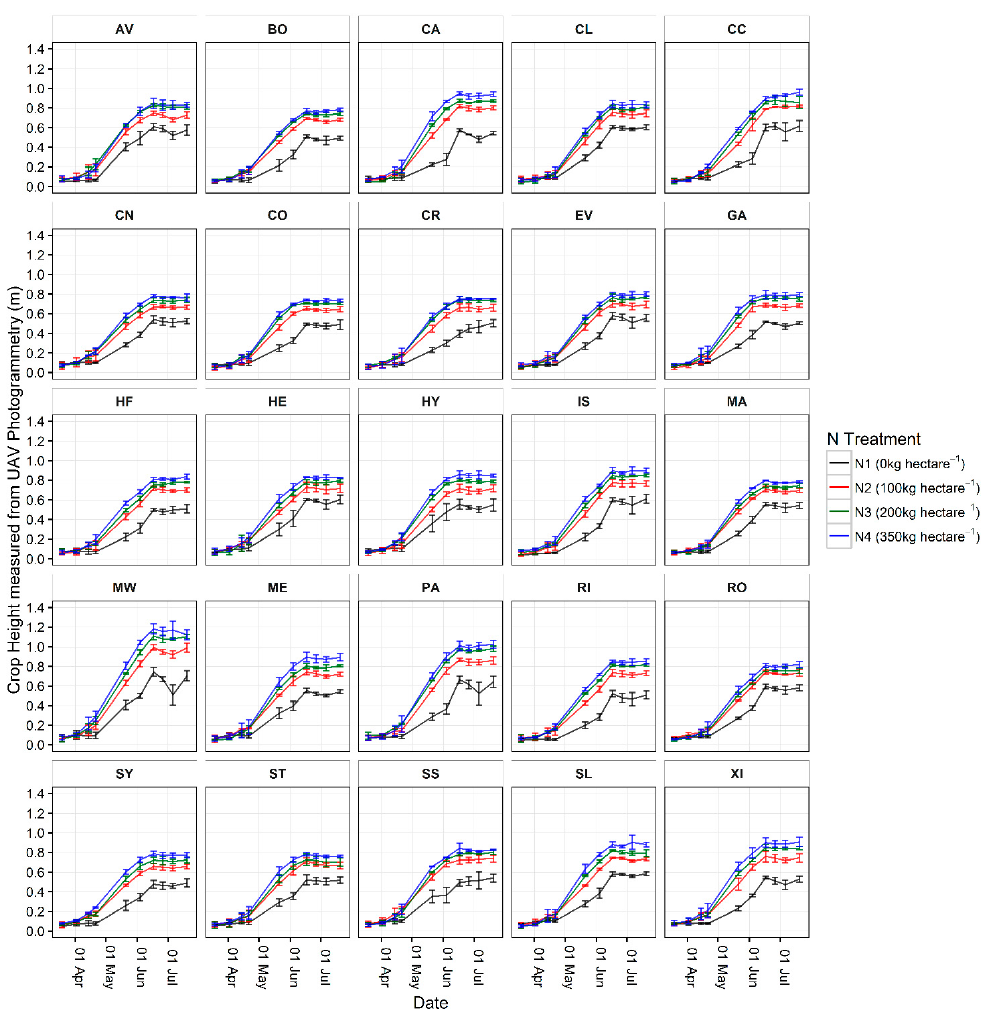
Figure 11. Changes in average crop height of the wheat varieties at the four N treatments. Variation in crop height between replicate plots is displayed by error bars. Crop varieties are referred to by their code as set out in Table 2 and all data are the means of three replicate plots, except Maris Widgeon N1 on the 4 June 2015 which is the mean of two replicates due to plot 298 being omitted because of noise in the model.